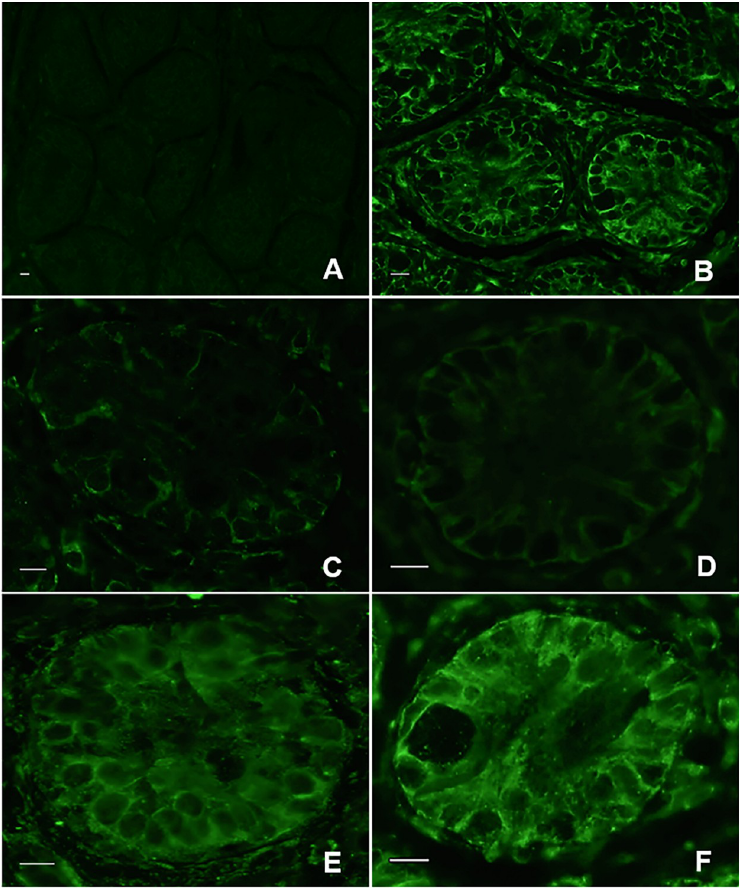
Fig 3. Vimentin in testicular tissue from prepubertal cats. (A) negative control, (B) fresh tissue, (C) Warming 1 (tissue warmed at 37˚C), (D) culture 1 (warming 1 followed by culture for 24h), (E) warming 2 (tissue warmed at 50˚C), (F) culture 2 (warming 2 followed by culture for 24h). Bar = 0.5 μ